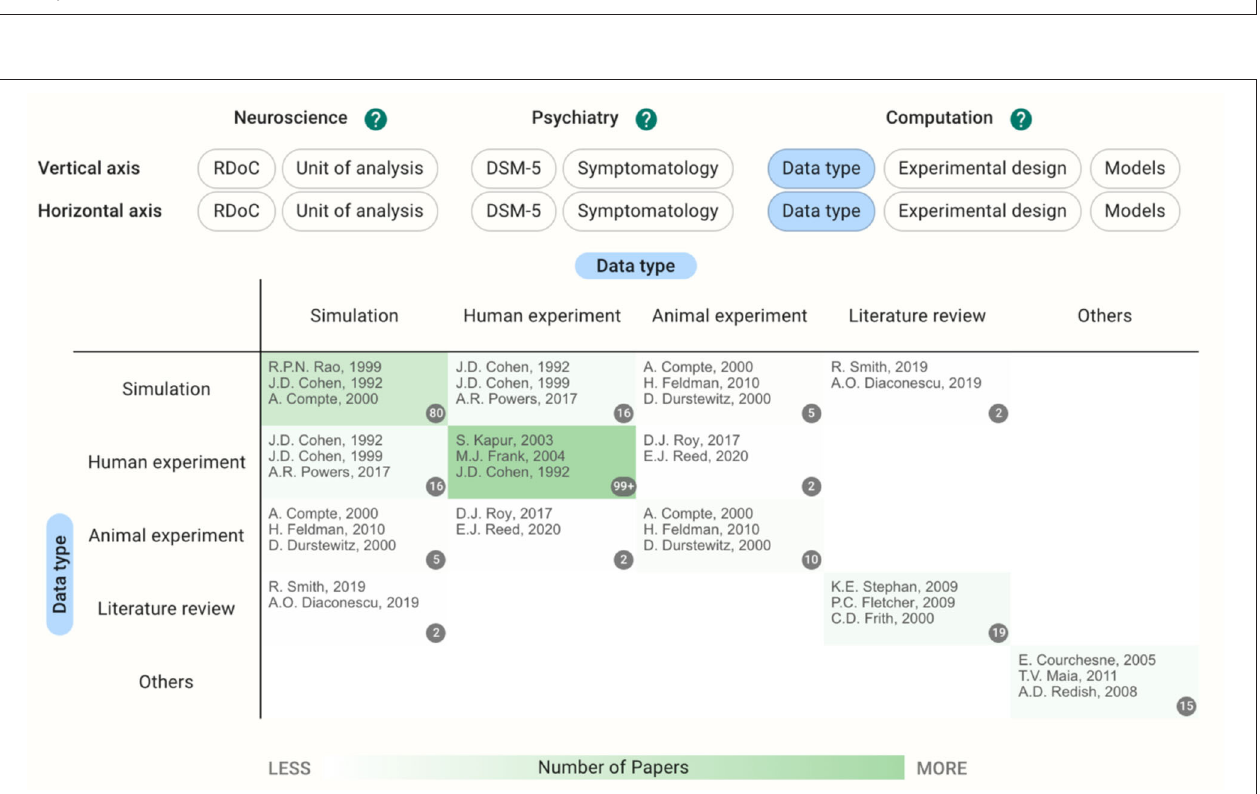
FIGURE 2 | Heatmap with data type in both horizontal and vertical axes showing the distribution of the papers on a single axis. Multiple selections of tags during the registration result in the papers outside of the diagonal cells.